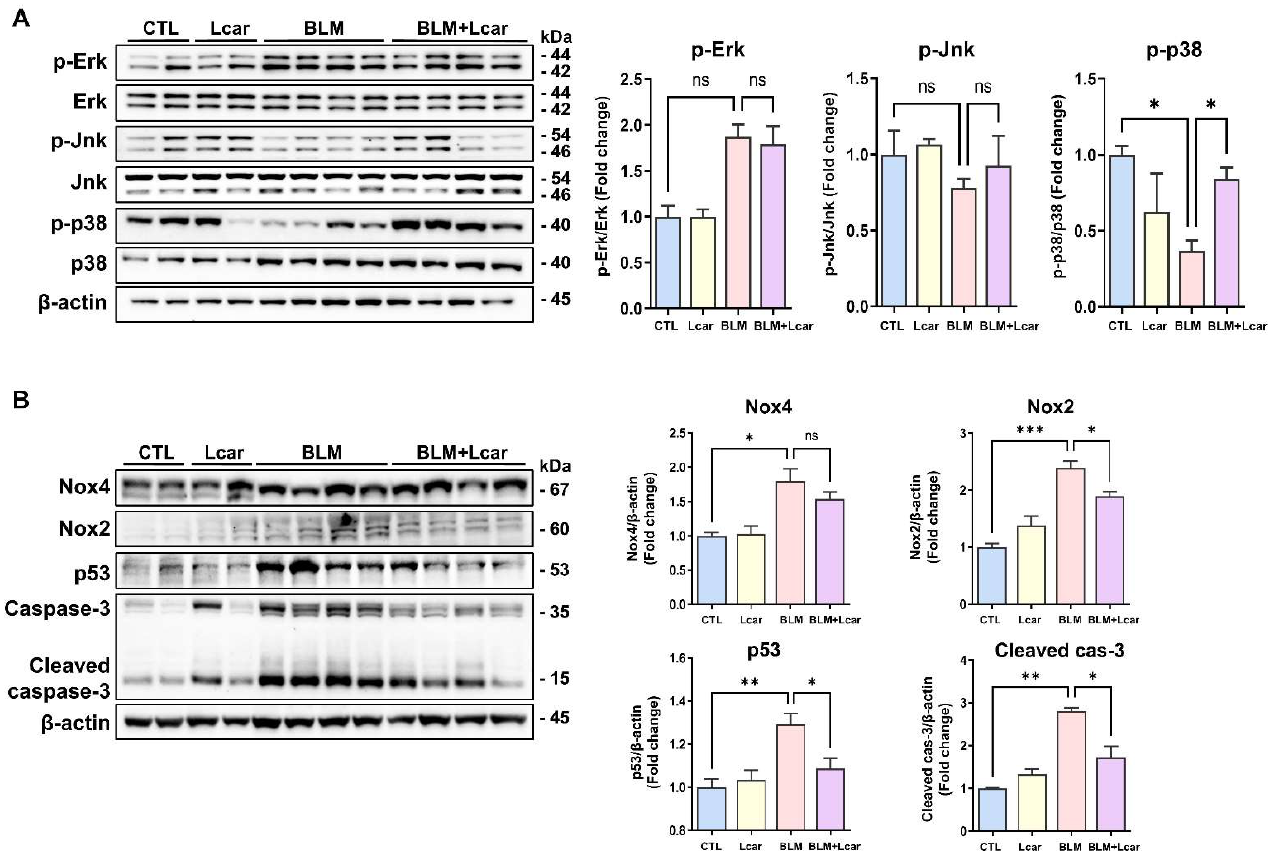
Figure 3. L-carnosine treatment protected alveolar injury via Nox2, Nox4-p53 and Caspase-3 medi- ated apoptosis. ( A ) Each protein was measured by Western blot. Relative density ratio graph of p-Erk, p-Jnk, and p-p38. All proteins were divided by each total form protein. ( B ) Proteins were measured by Western blot. Relative density ratio graph of Nox2, Nox4, p53, and Cleaved caspase-3. All proteins were divided by β -actin. A value of * p < 0.05, ** p < 0.01, and *** p < 0.001 was compared with each indicated group by one-way ANOVA. CTL, Control; L-car, L-carnosine; BLM, Bleomycin; cas-3, caspase-3 .